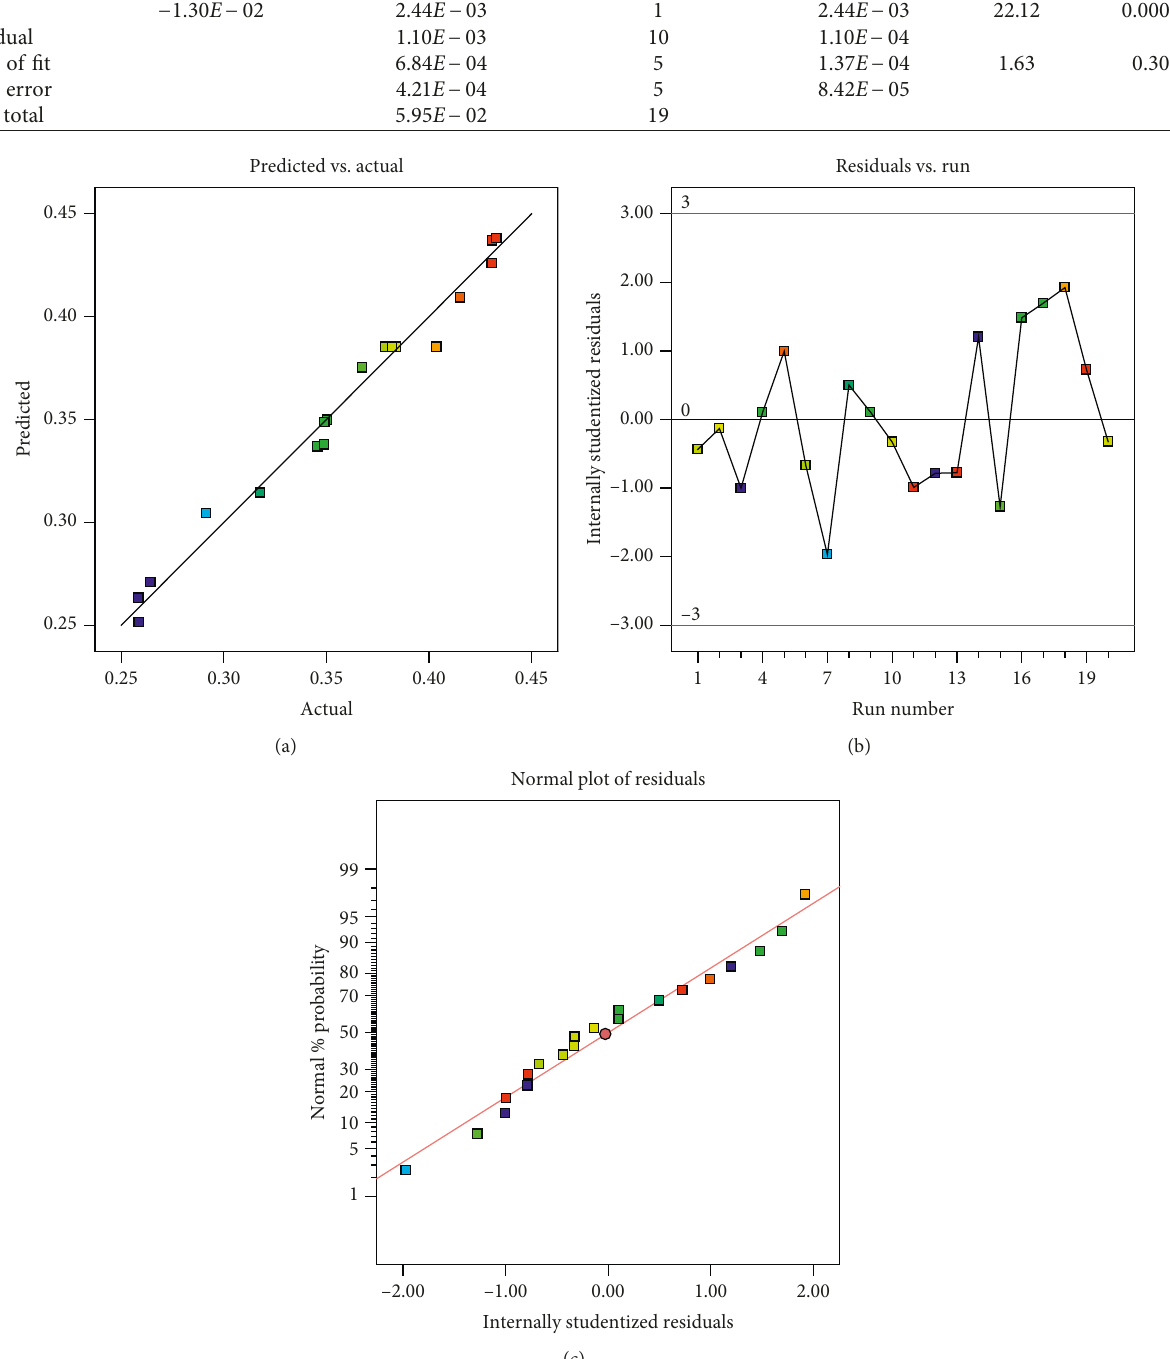
Figure 3: Diagnostic plots of the quadratic model. (a) Diagnosis of experimental and predicted values of TF extraction rate. (b) Plot of internally studentized residuals for TF extraction rate. (c) Normal probability plot for TF extraction